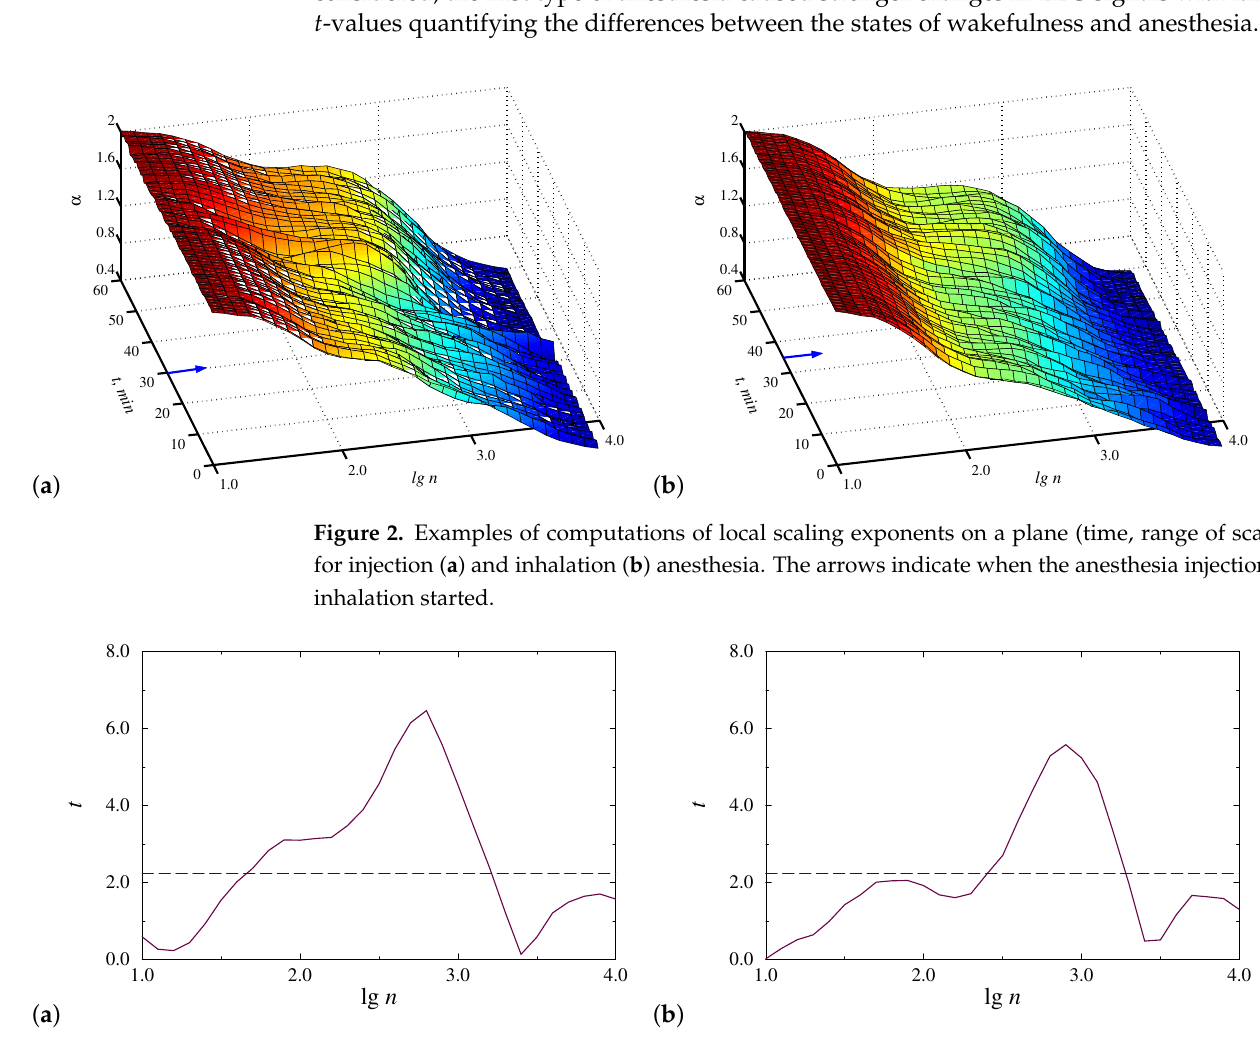
Figure 3. Estimates of t -values of the Student’s t -test for EEG signals for injection ( a ) and inhalation ( b )